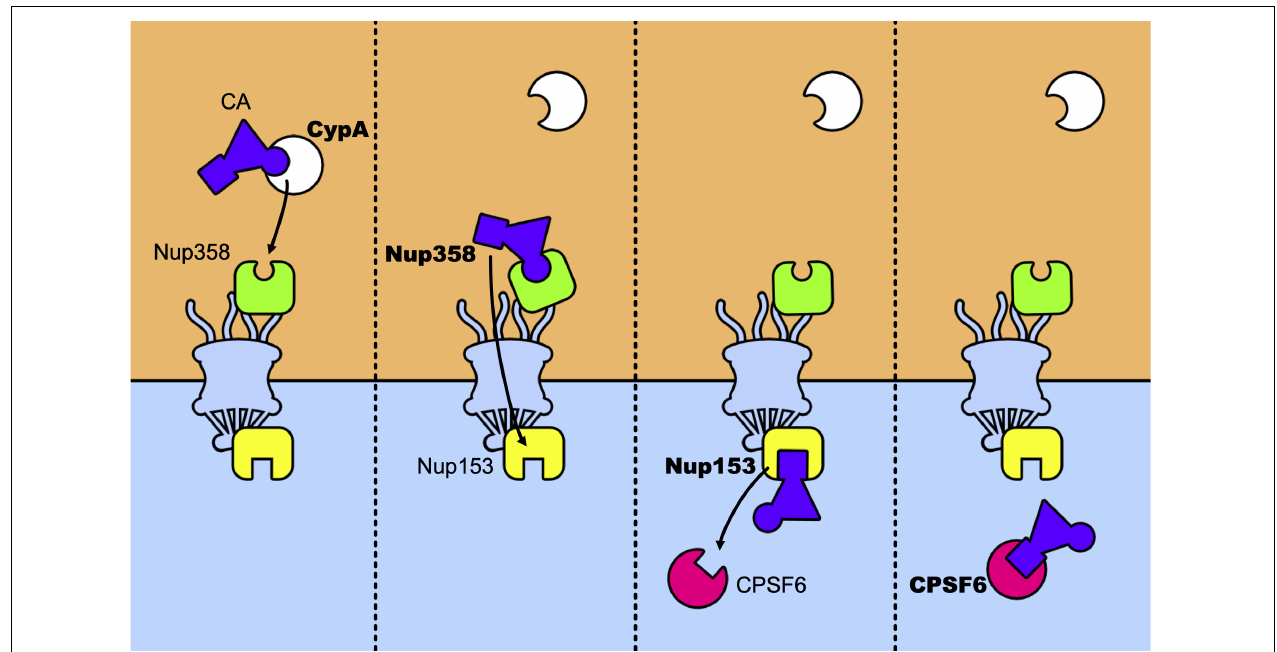
FIGURE 5 | Relay race of the capsid core in the host cell. From left to right a temporal view of how CA is passed between host factors in its trip toward the nucleus. The capsid core is schematically represented as a purple triangle with two host factors binding sites highlighted: the CypA binding-loop (the circle) and the NTD-CTD pocket (the square). The first to bind to the core is CypA, which recognizes the CypA-binding domain, located in the CA-NTD. The same binding site is recognized by Nup358 and its binding anchors the capsid core at the NPC, allowing its nuclear import. Then, Nup153 binds to the NTD-CTD pocket of the assembled capsid, which is the same recognition site of CPSF6. When CPSF6 takes the place of Nup153 on the binding site it can translocate the capsid core (intact or not) to deeper nuclear